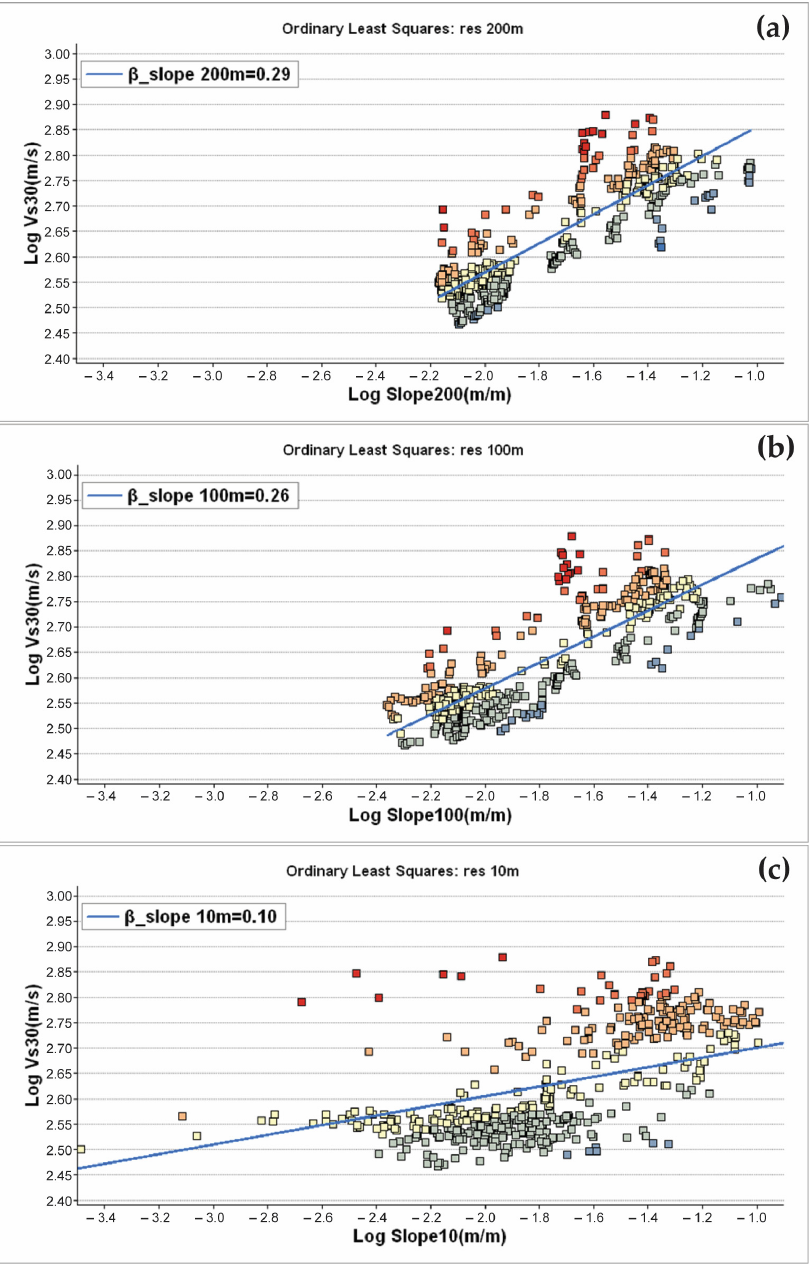
Figure 9. Correlations obtained between log ( V s30 [m/s]) and log ( slope [m/m]), for Almeria city using different slope map resolutions: ( a ) 200 m; ( b ) 100 m; ( c ) 10 m.